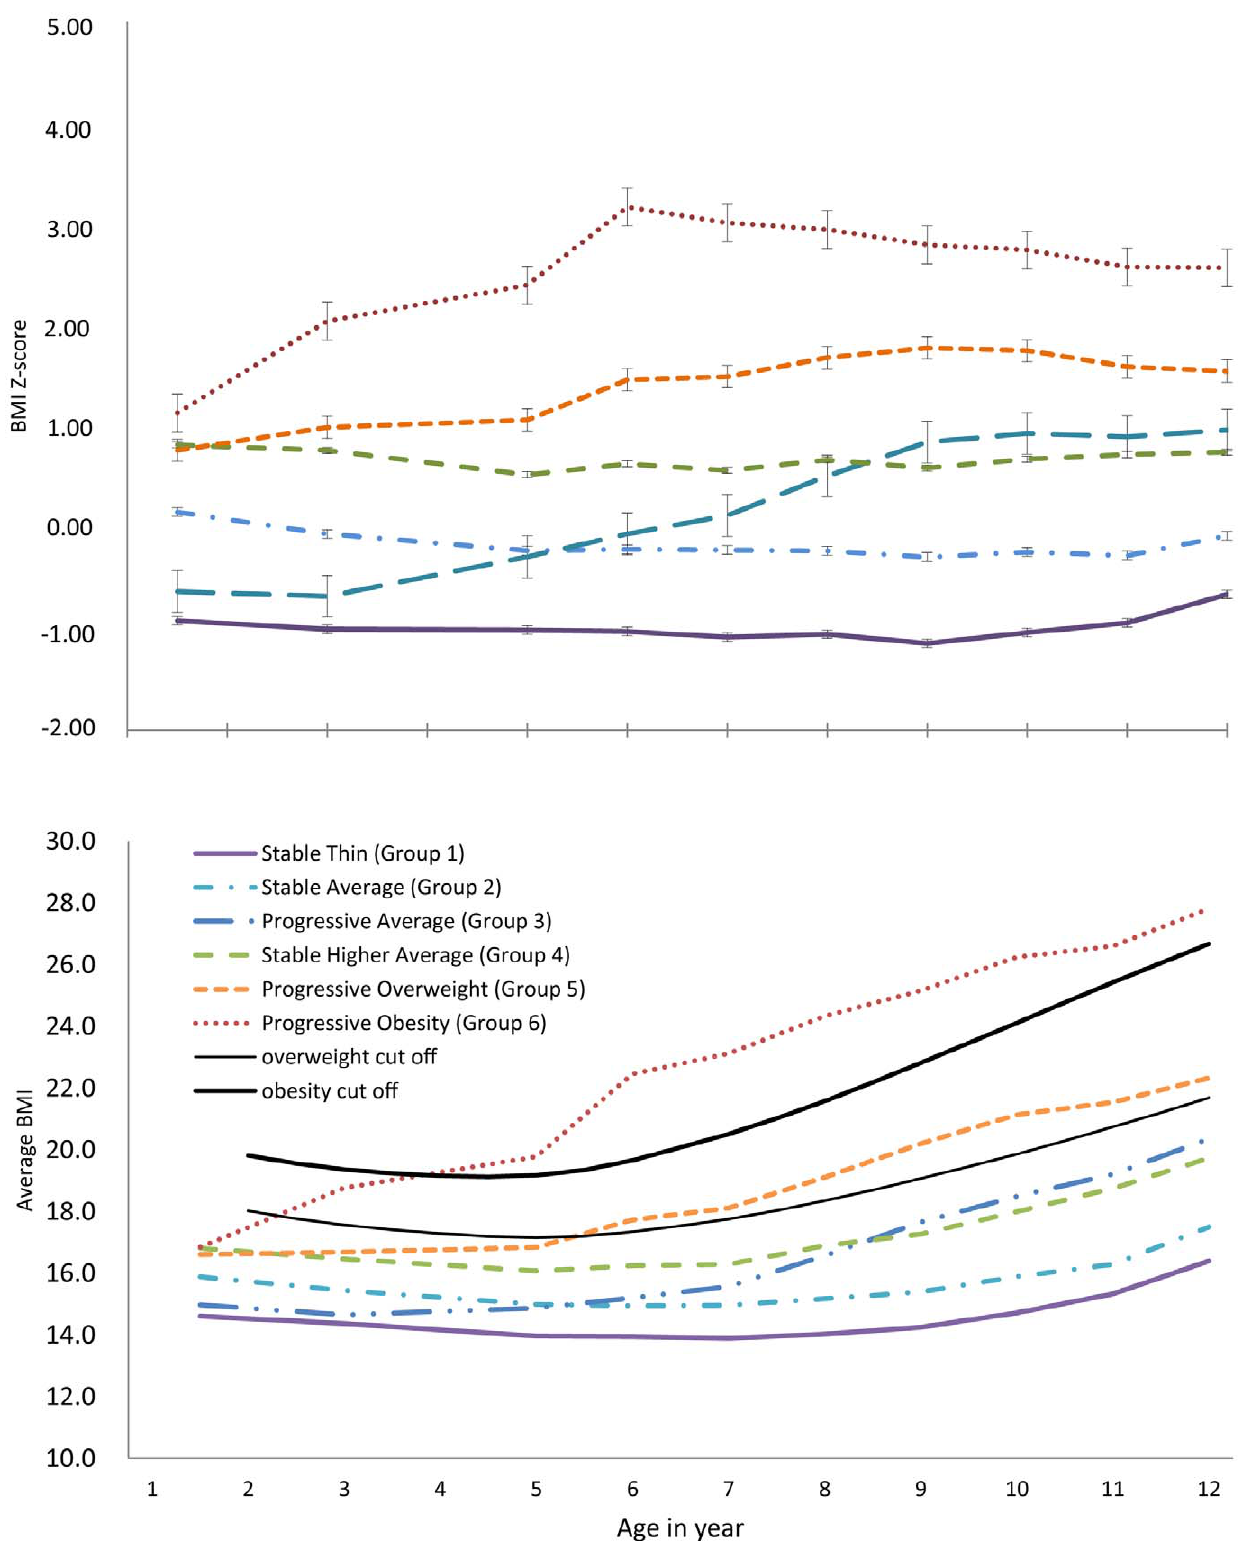
Figure 2. Trajectories of Body mass index (BMI) and the average BMI of girls aged 1.5 to 12 years in Koshu City, Japan, 1991–1998. Error bars indicate the standard error of the mean for each observed group. Group 1, ‘‘stable thin’’; Group 2, ‘‘stable average’’; Group 3, ‘‘progressive average’’; Group 4, ‘‘stable high average’’; Group 5, ‘‘progressive overweight’’; Group 6, ‘‘progressive obesity.’’